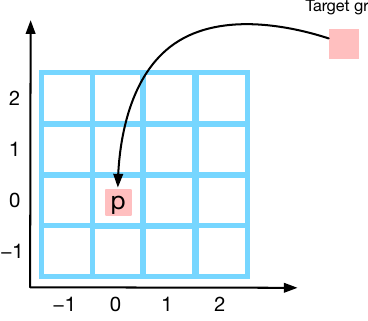
Figure A1. The bicubic mapping in